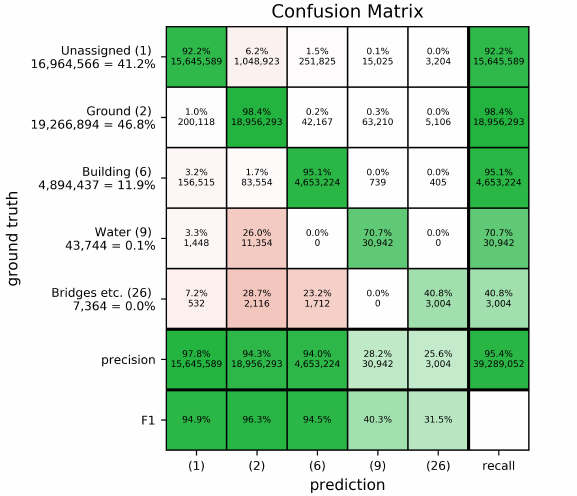
Figure 7. Detailed AHN3 test set results using 0 . 5 m voxel